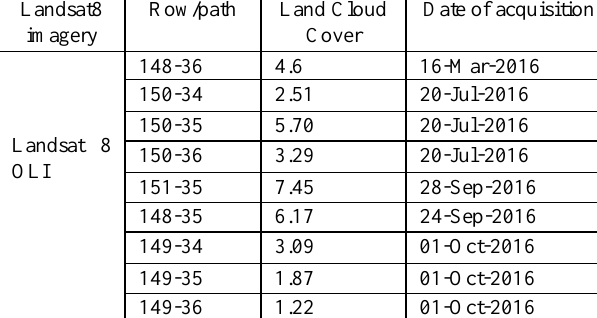
Table 2. Landsat 8 Operational Land Imager (OLI) and Thermal Infrared Sensor (TIRS) Launched 2016.